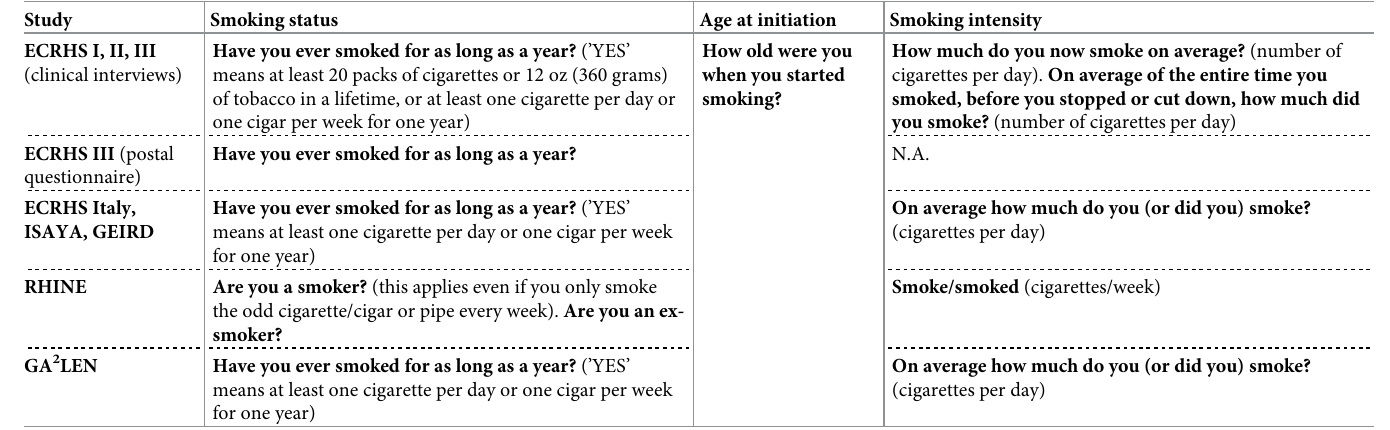
Table 2. Questionnaire items on